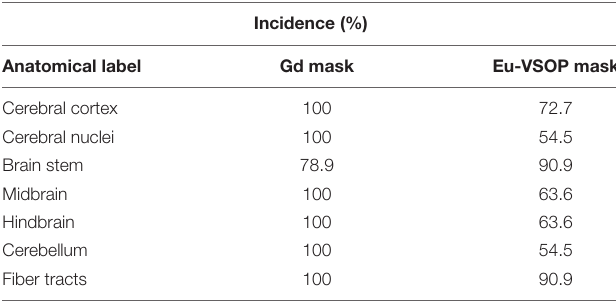
TABLE 1 | Incidence of Gd-enhancement and Eu-VSOP